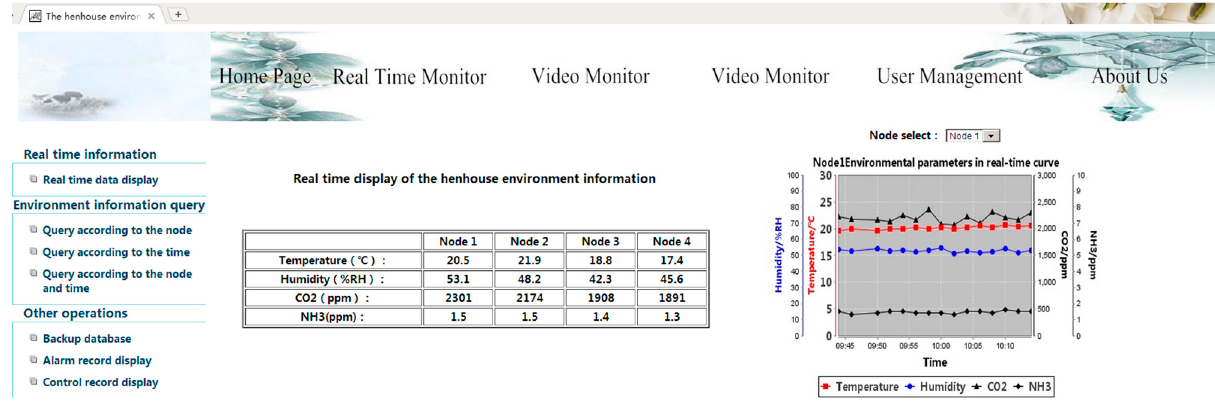
Figure 6. Real time monitoring